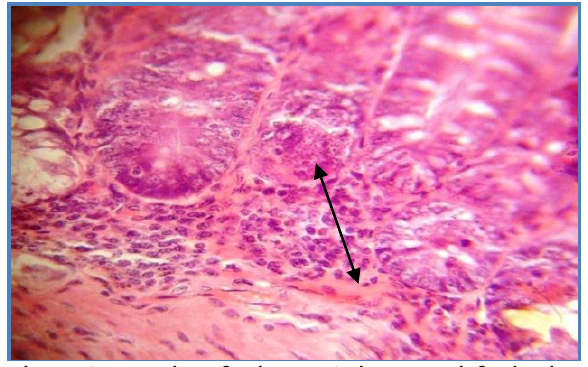
Figure, 8: Intestine of mice at 10 days post infection by Candida albicans and treated with 15% of Datura stramonium extract for 8 days ( ) shows mononuclear cells infiltration between mucosal gland (H and Es 40X).